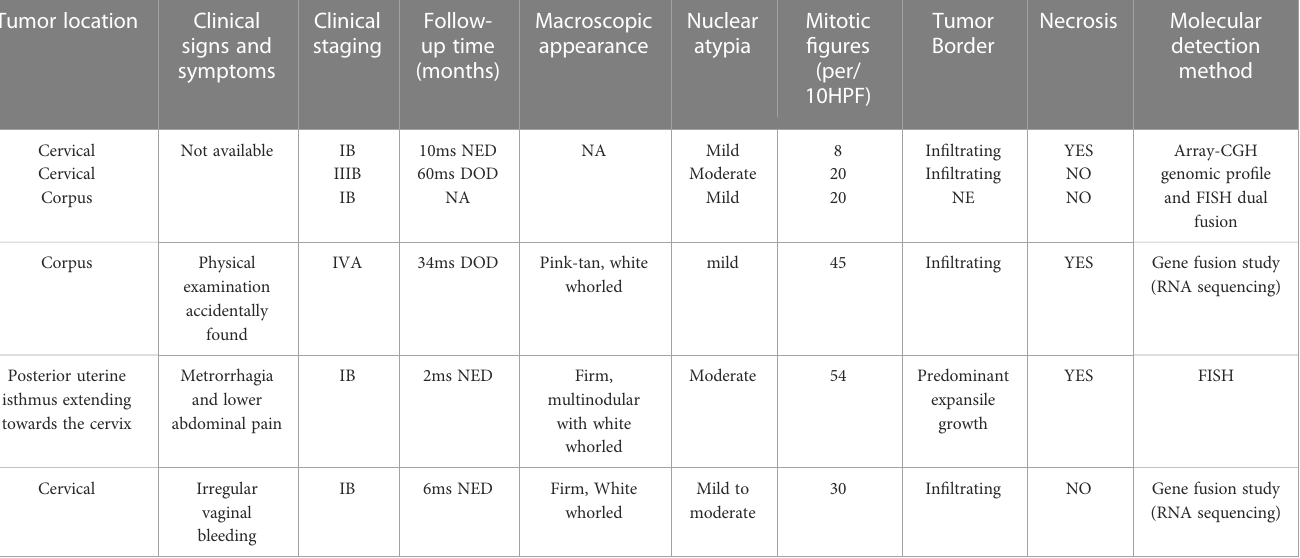
TABLE 2 Clinicopathological fi ndings of COL1A1 – PDGFB fusion uterine sarcoma in this case and comparison with previous cases in the